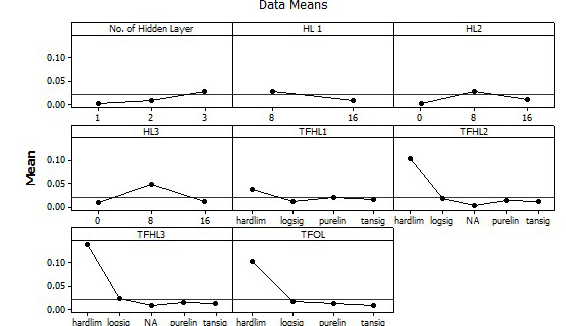
Fig. 8. Main Effects Plot for Training R Fig. 9. Main Effects Plot for Validation Performance